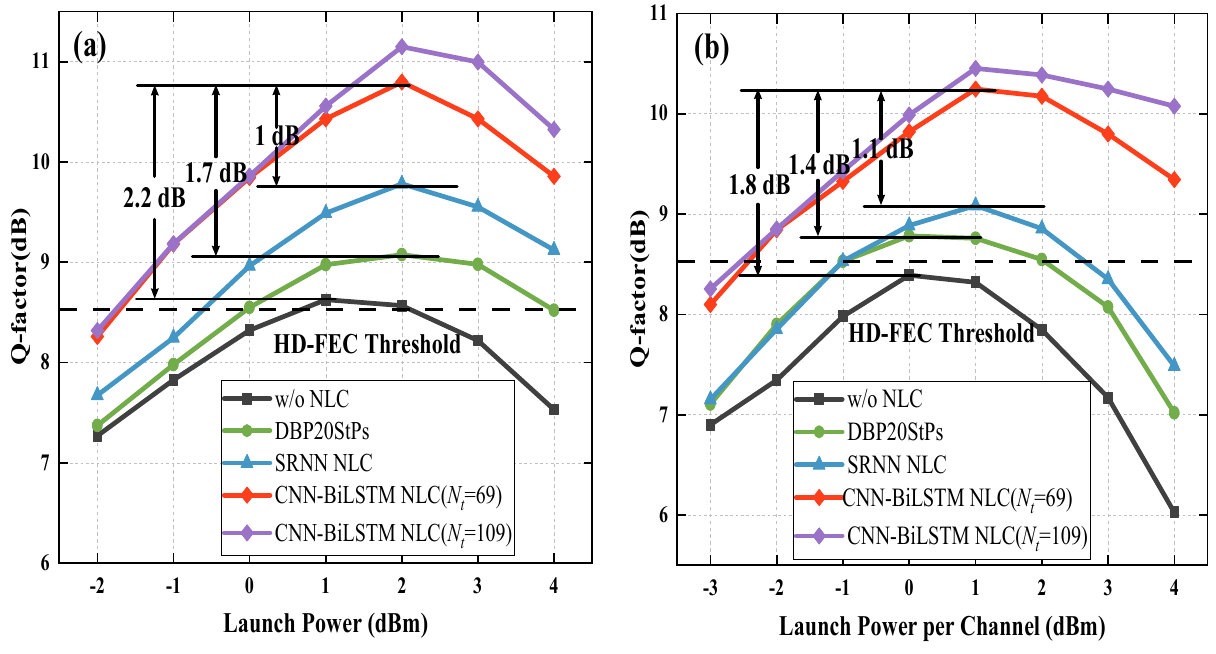
Figure 14. Q-factor of different NLC schemes versus launch power for 28 GBaud PDM-16QAM transmission system over 800 km. ( a ) SC; ( b )